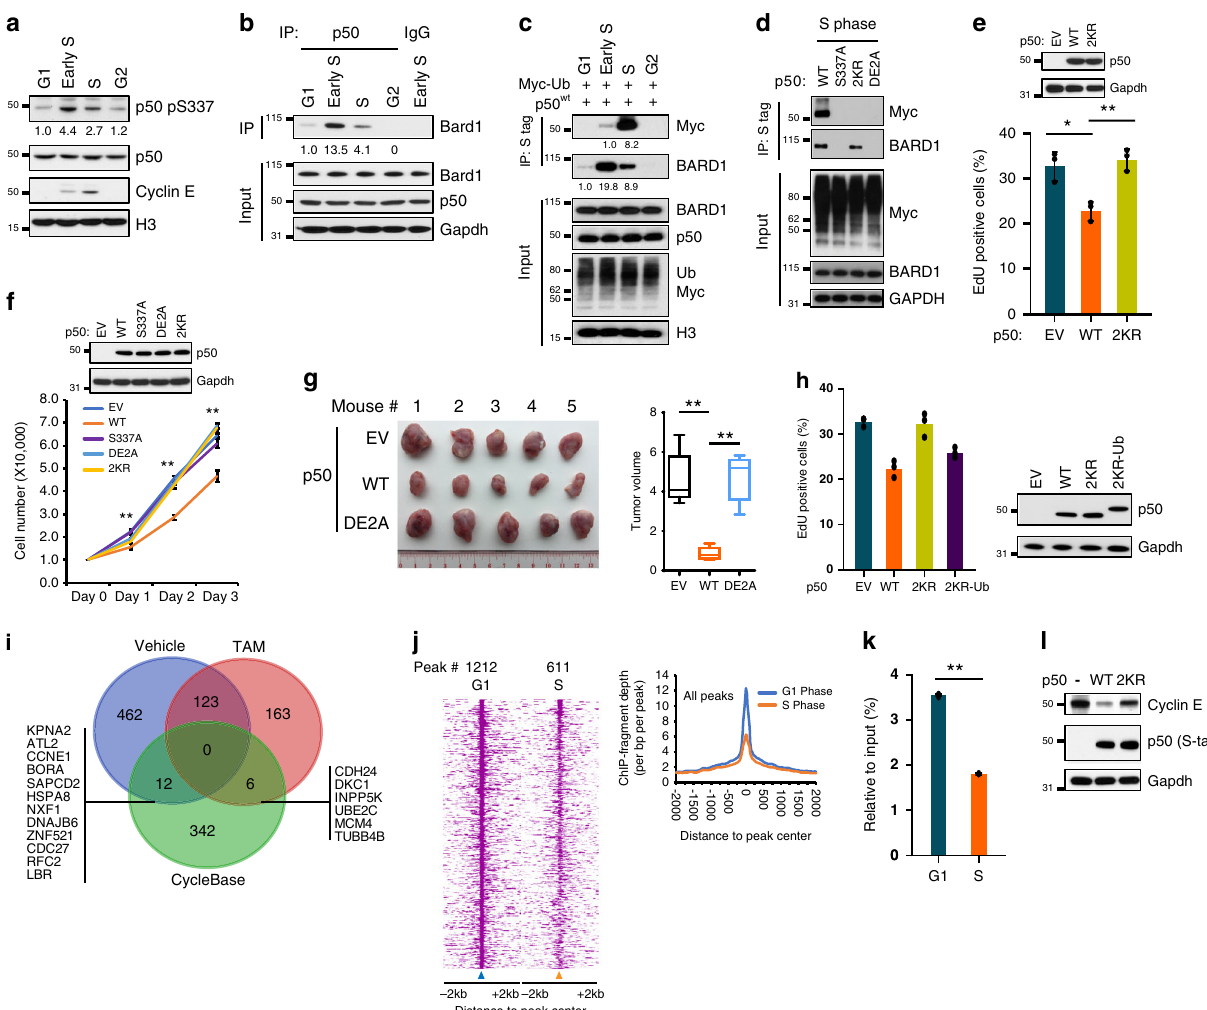
Fig. 6 p50 mono-ubiquitination regulates cell cycle progression. a Synchronized primary WT MEFs were harvested at the indicated cell cycle stage and nuclear fractions isolated. IB using anti-p50-pS337, anti-p50, and anti-Cyclin E. b Co-IP in primary WT MEFs synchronized and released as in a . IP with anti-p50 or IgG and IB with anti-Bard1 or indicated antibody. c 293T cells transfected with Myc-Ub and S-tag p50 wt were harvested at the indicated cell cycle stage and nuclear extract used for IP with S-agarose followed by IB with anti-Myc or anti-BARD1 antibody. d 293T cells transfected with Myc-Ub and p50 constructs were harvested at S phase. IP of nuclear fractions with S-agarose and IB with anti-Myc or anti-BARD1. e Immortal Nfkb1 -/- MEFs stably expressing empty vector (EV), p50 wt (WT), or p50 2KR (2KR) were pulsed with 5-ethynyl-2 deoxyuridine (EdU) and positive staining quanti fi ed. Data show mean value from n = three biologically independent experiments, ± SEM. * P = 0.012, ** P = 0.004, two-sided Student ’ s t -test. Inset: IB with anti-p50. f Immortal Nfkb1 -/- MEFs stably expressing EV or the indicated p50 mutant were plated and cell number counted every 24 h. Data show mean number from three biologically independent experiments, ± SEM. ** P < 0.001, EV vs. WT, two-sided Student ’ s t -test. g Immortal Nfkb1 -/- MEFs stably expressing the indicated construct were injected into fl anks of nude mice and tumors harvested at 2 weeks. Representative experiment (left panel, n = 5 animals). Box plot: center-line is median, box limits represent upper and lower quartiles and whiskers are minimum and maximum. ** P < 0.001, two-sided Student ’ s t - test. h Immortal Nfkb1 -/- MEFs stably expressing EV, p50 wt , p50 2KR , or p50 2KR-Ub (2KR-Ub) were pulsed with EdU and positive staining quanti fi ed. Data show mean value from two biologically independent experiments. i Venn diagram illustrating overlap between genes associated with p50-binding peaks in ChIP-Seq analysis from Fig. 5 and periodically regulated genes from Cyclebase 3.0. j ChIP-seq analysis of p50-binding peaks. Heatmap (left) and histogram (right) for average peak intensity was plotted for ChIP-Seq data from cells synchronized at G1 and S phase. k ChIP-qPCR of p50 binding to the CCNE1 promoter in 293T cells at the indicated cell cycle phase. Data show mean enrichment of p50 relative to input and IgG control, ± SEM. from n = 3 biologically independent experiments.** P < 0.001, two-sided Student ’ s t -test. l IB using Nfkb1 -/- MEFs expressing EV, S-p50 wt or S-p50 2KR using anti-Cyclin E and anti-S tag. All blots are representative of at least two biologically independent experiments. Analysis of fold-change normalized to control lane shown below IB where